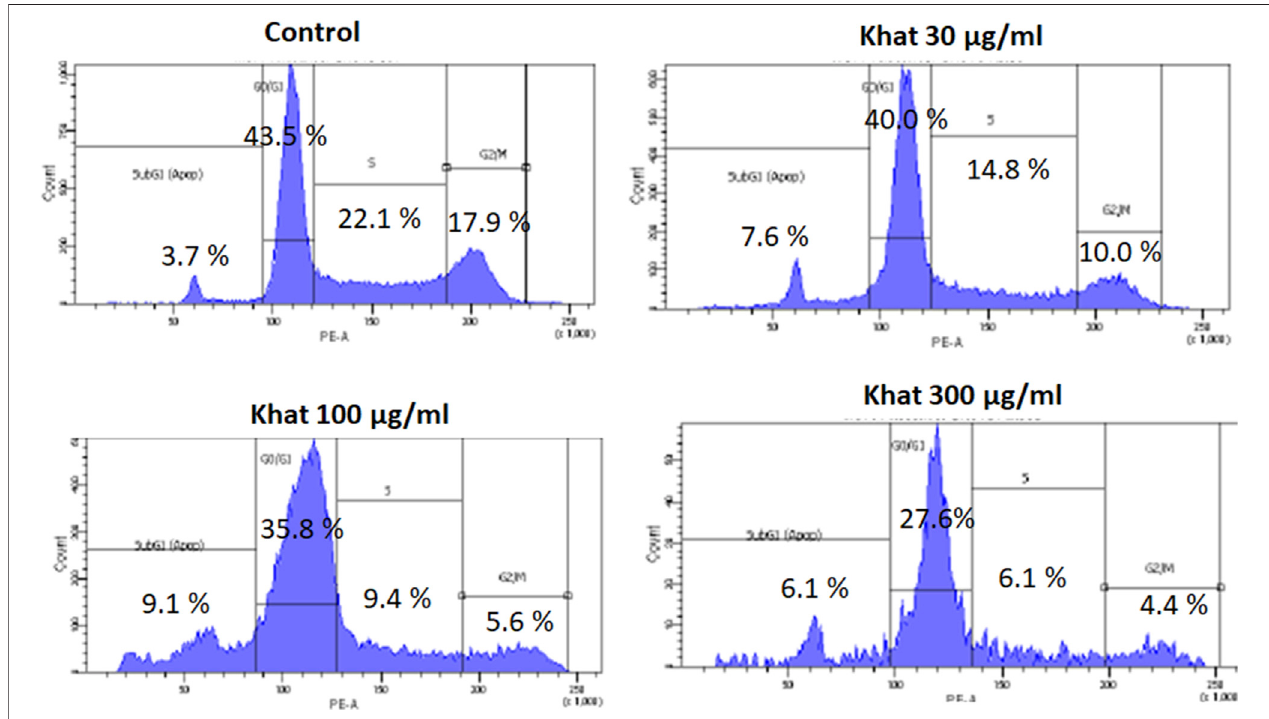
FIGURE 3 | Cell cycle (Propidium iodide assay) of SKOV3 following treatment with khat extracts at different concentrations (30 μ g/ml, 100 μ g/ml, and 300 μ g/ml) for 48 h. There was a mild increase in the sub-G1 phase of the cell cycle indicative of